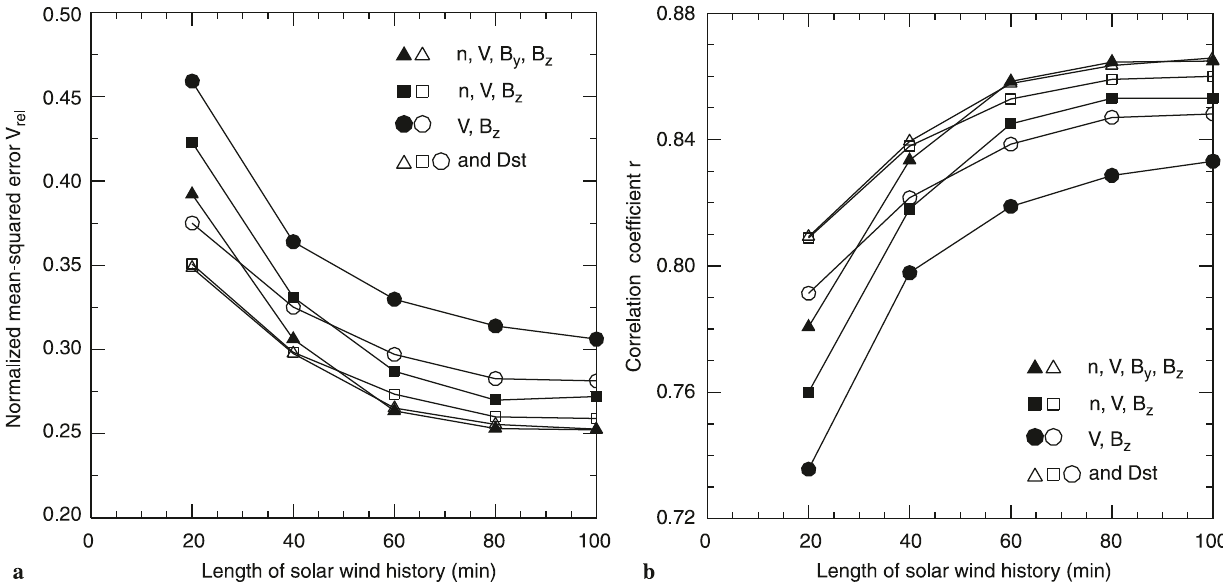
predictions from Dst and the solar wind. The AE predictions are only improved by Dst if less than the optimum solar-wind data are available to